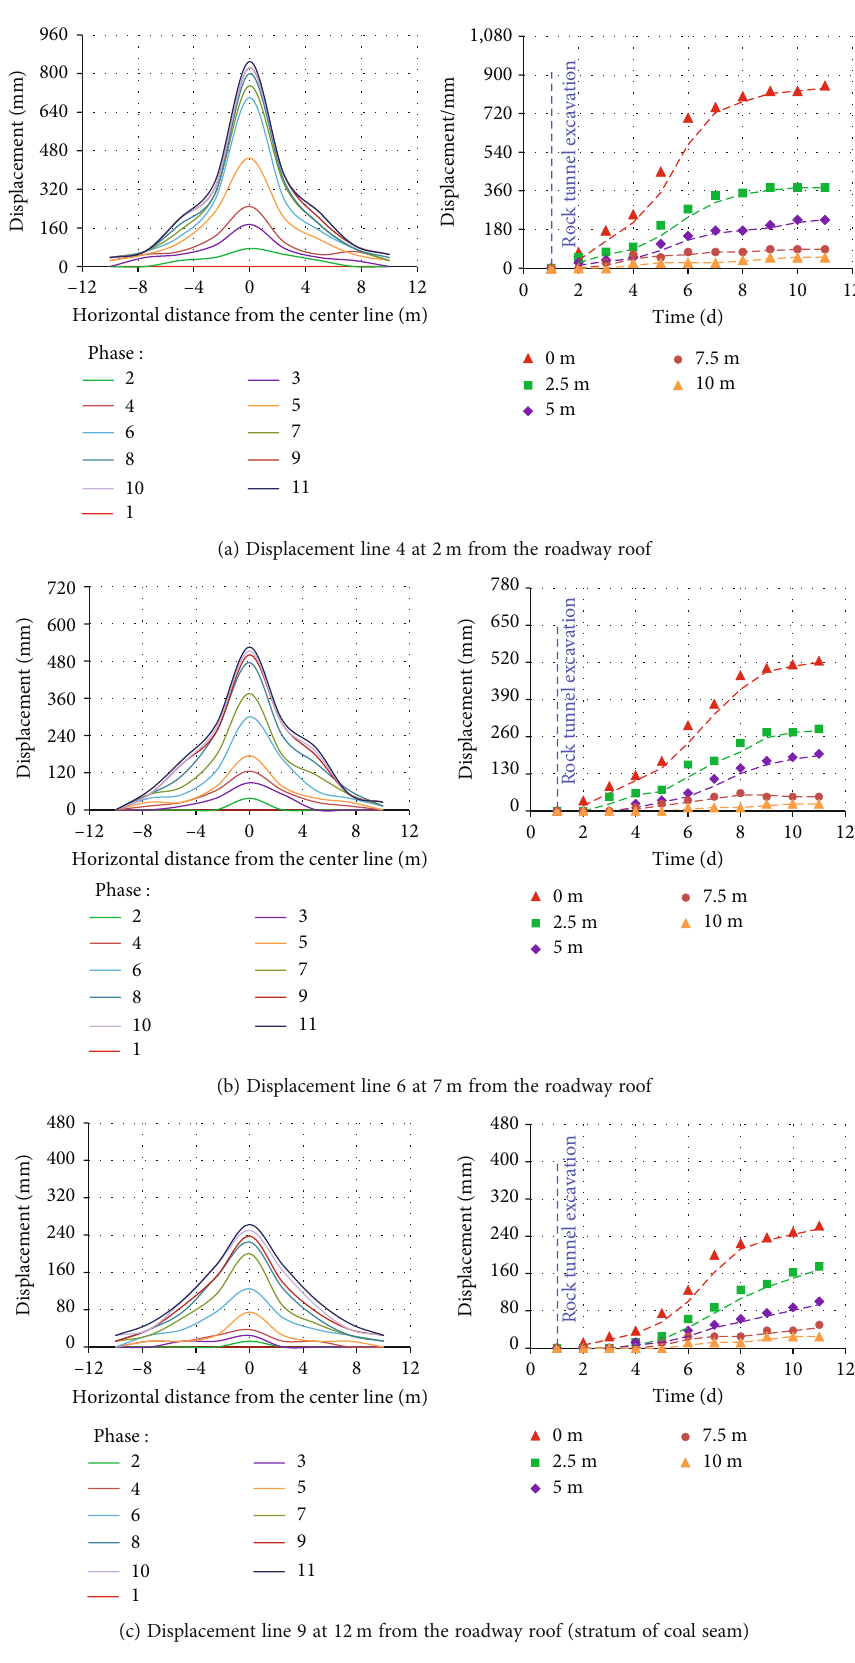
Figure 8: Roof displacement curves in di ff erent loading phases after fl oor roadway